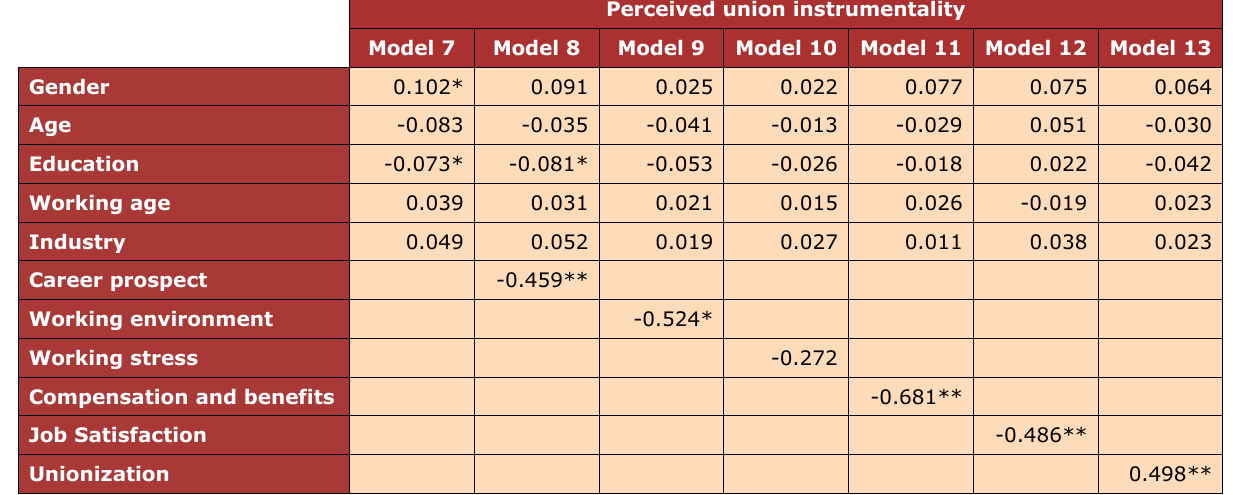
Table 3. Regression analysis for the perceived union